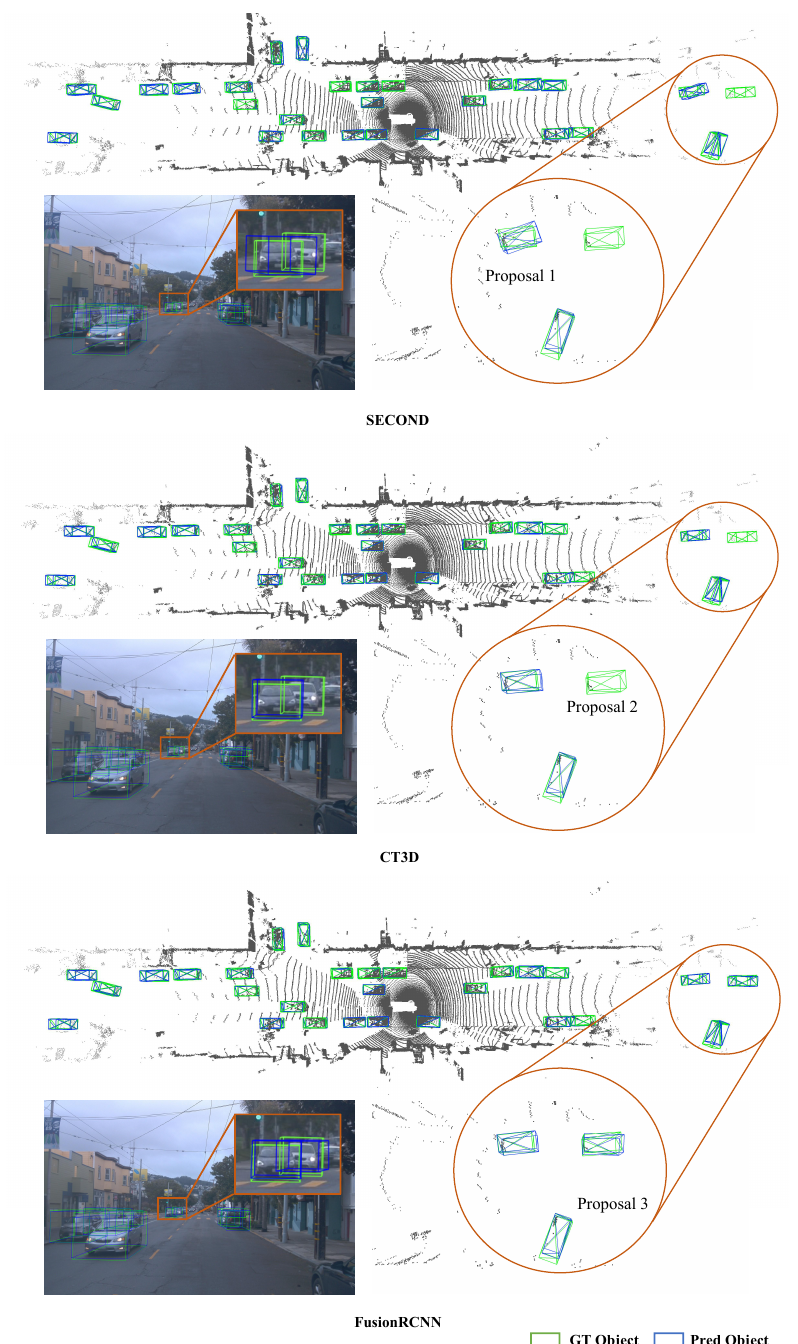
Figure 4. Qualitative comparison between LiDAR-based two-stage detector (CT3D) and our Fusion- RCNN on the Waymo Open Dataset. Ground-truth and predictions are painted in Green and Blue, respectively. Three proposal vehicles in red circles are zoom-in and visualized on 2D images and 3D point clouds. Our FusionRCNN works better than CT3D with only LiDAR input in long-range